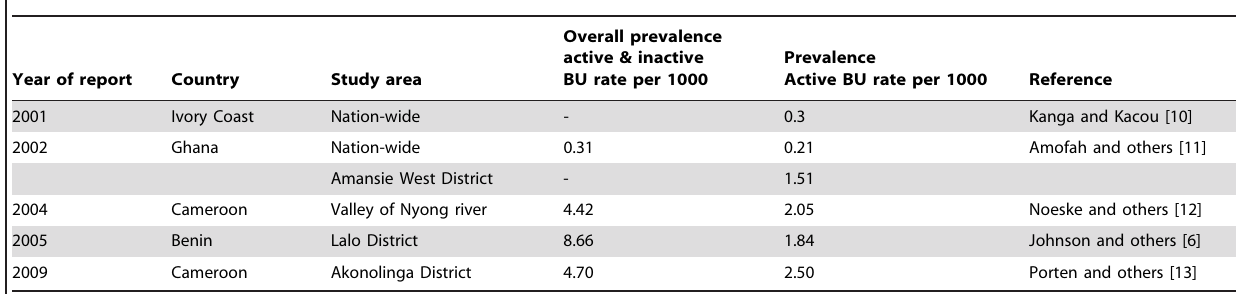
Table 1. Prevalence of Buruli ulcer disease in